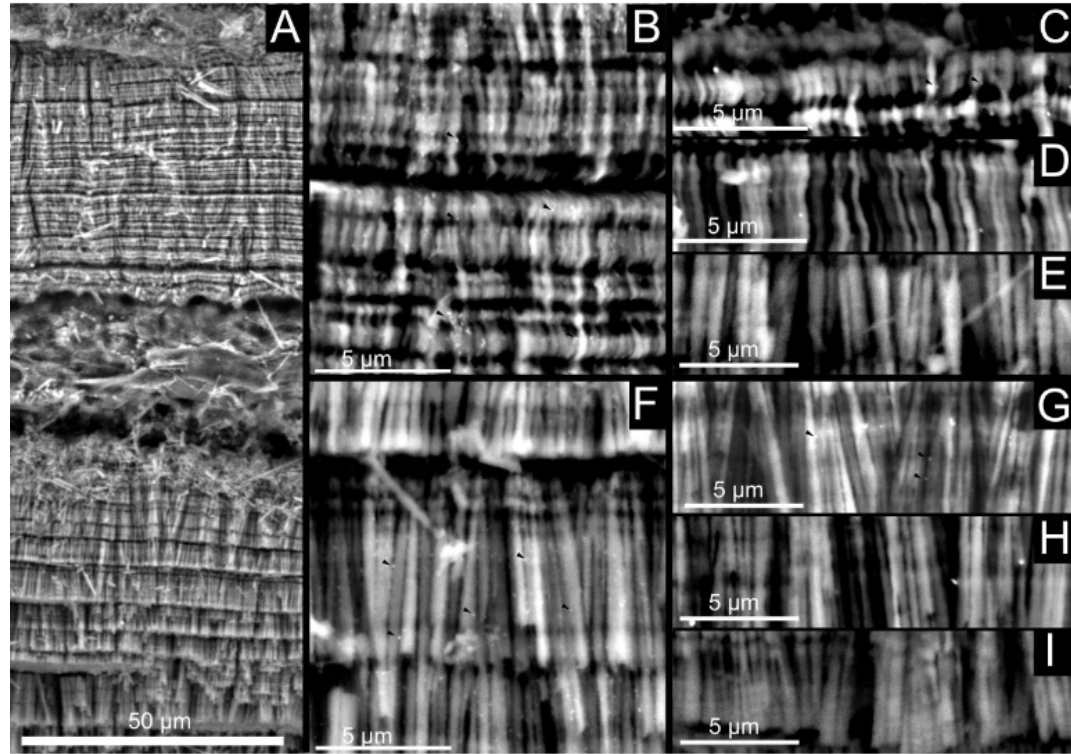
Figure 11. Lectin-gold labeling of shell preparations with biotinylated concanavalin A. The left panel ( A ) shows a general view of the shell wall, while the middle panel represents magnification of the outer ( B ) and inner ( F ) layers. The right panel corresponds to different negative controls, namely without the lectin ( C, G ), without the GABIO ( D, H ) and an absolute blank ( E, I ). A, B and C show that the labeling is diffuse in the mineralized layers.